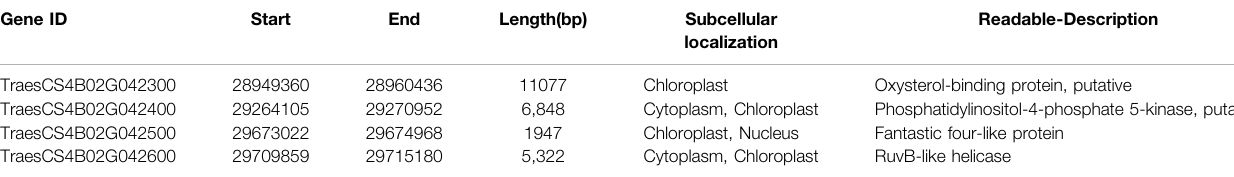
TABLE 1 | Information about the basic candidate genes.